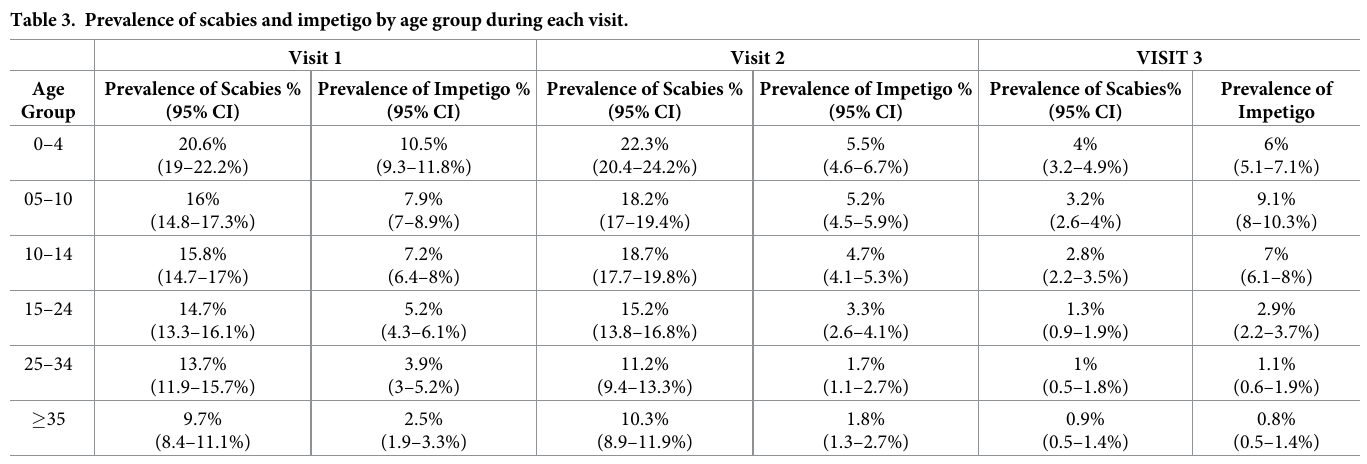
Table 3. Prevalence of scabies and impetigo by age group during each